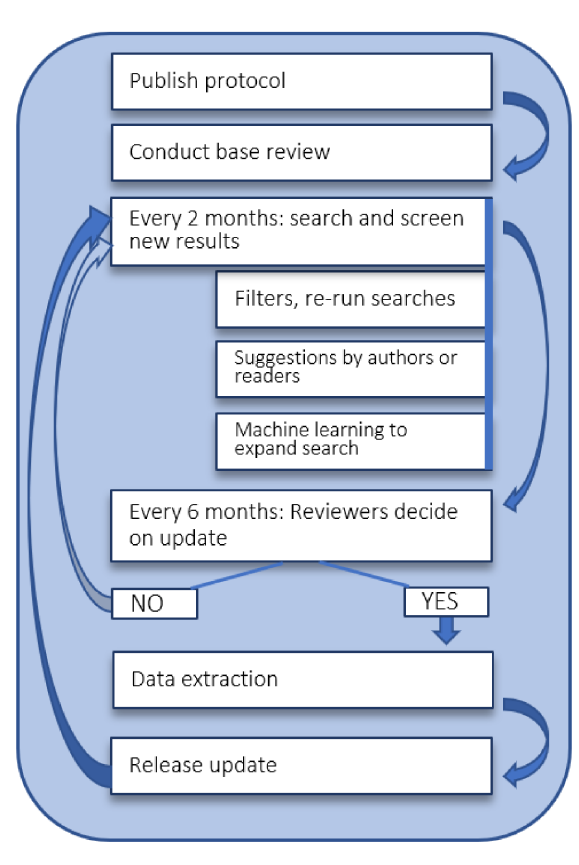
Figure 2. Continuous updating of the living